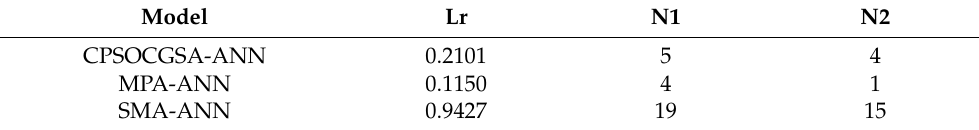
Table 1. ANN hyperparameters based on the CPSOCGSA-ANN, MPA-ANN, and SMA-ANN algorithms. Model Lr N1